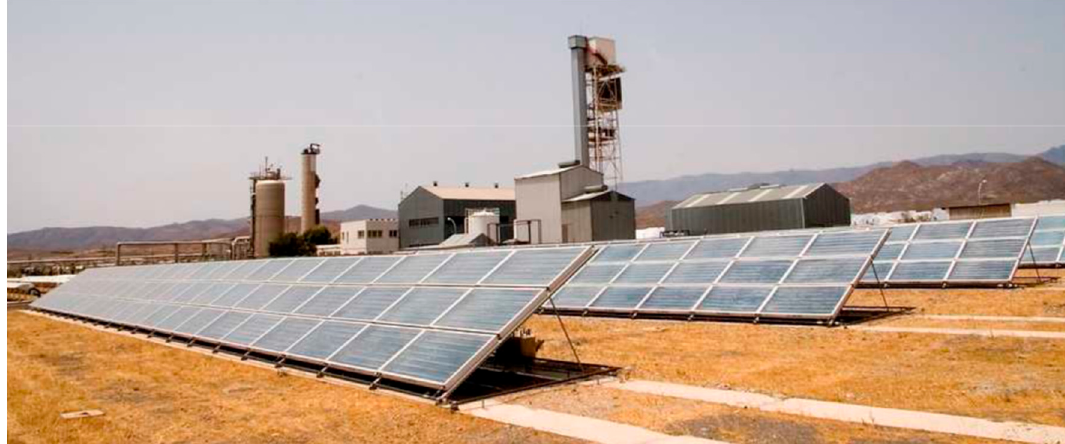
Figure 40. A 500 m 2 stationary CPC solar collector field [74].